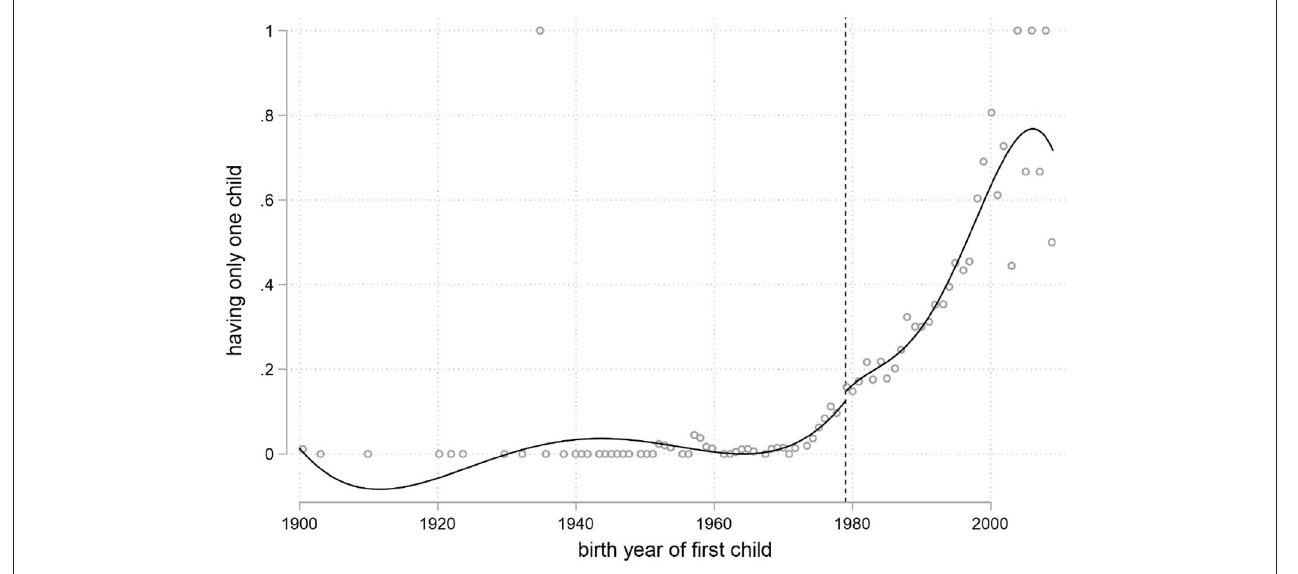
FIGURE 2 | The impact of the one-child policy on individuals’ fertility.